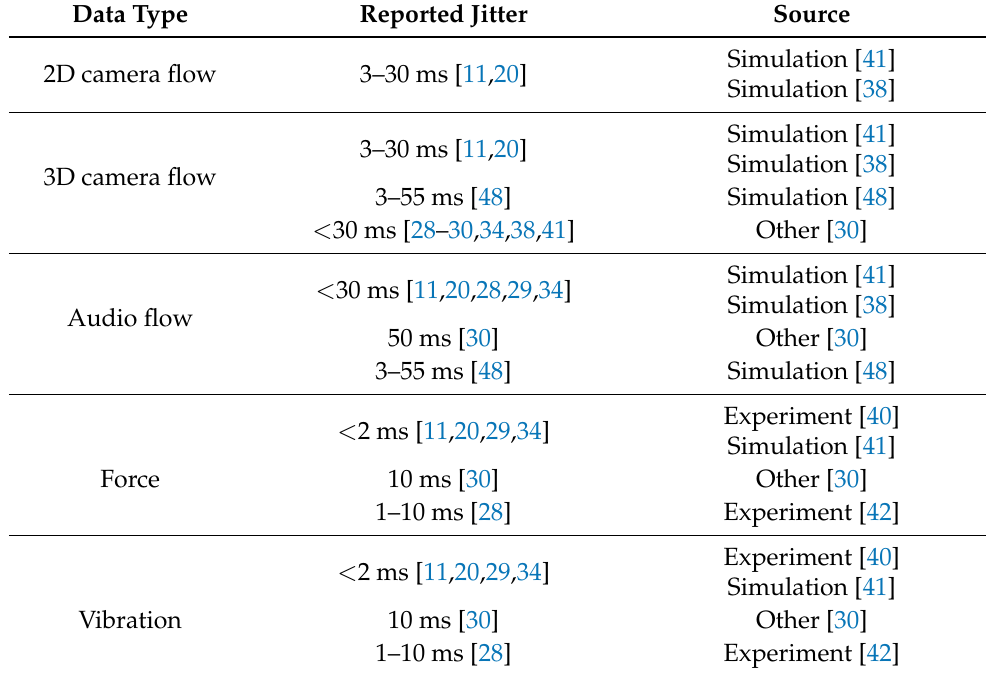
Table A2. Jitter requirements for telesurgery.